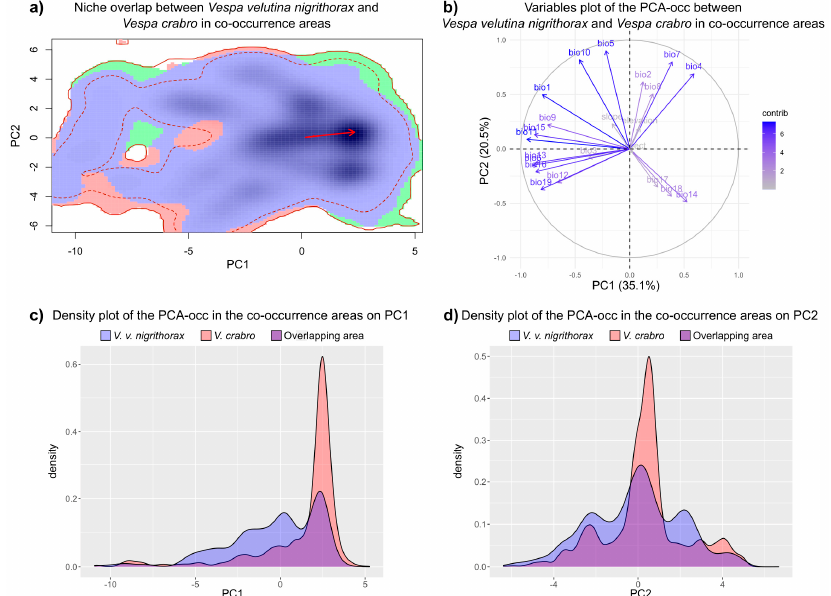
Figure 6. Results of the climatic niche analysis (PCA-occ) in the areas of co-occurrence of Vespa velutina nigrithorax and V. crabro . ( a ) shows the realised climatic niches of V. v. nigrithorax (red) and V. crabro (green). Niche overlap is highlighted in blue. The solid and dashed contour lines illustrate, respectively, 100 and 50% of the available (background) environment. The red arrow represents how the centre of the niche changes between species. ( b ) show the variables plot of the PCA-occ analysis along the first two principal components (PC1 and PC2). ( c , d ) report the density plots of the PCA-occ along the first two components, respectively, PC1 and